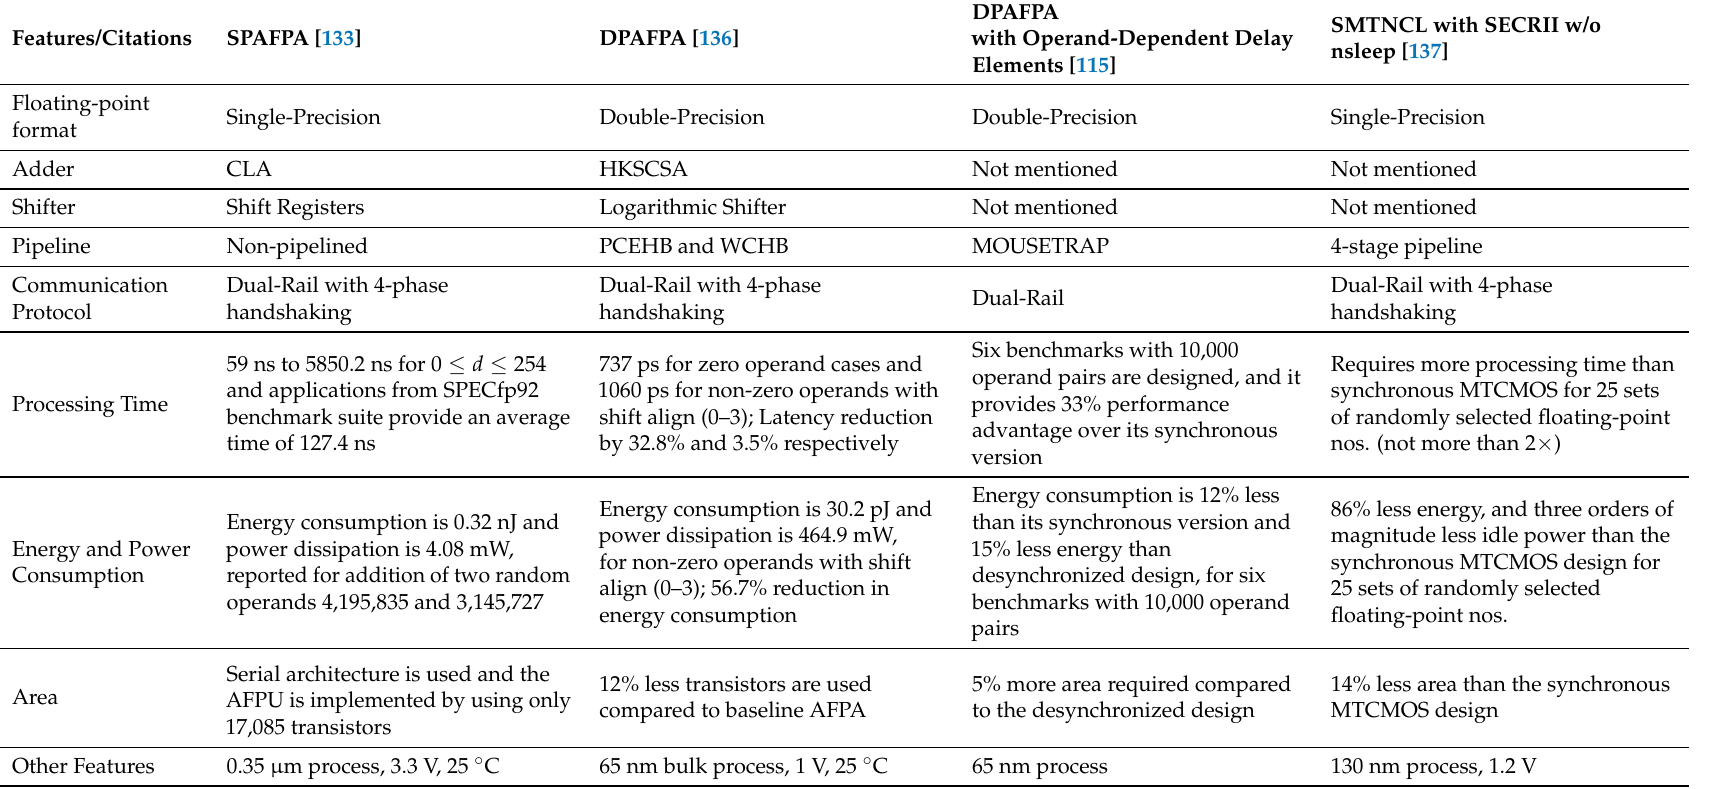
Table 3. Comparison of existing asynchronous floating-point adder (AFPA)